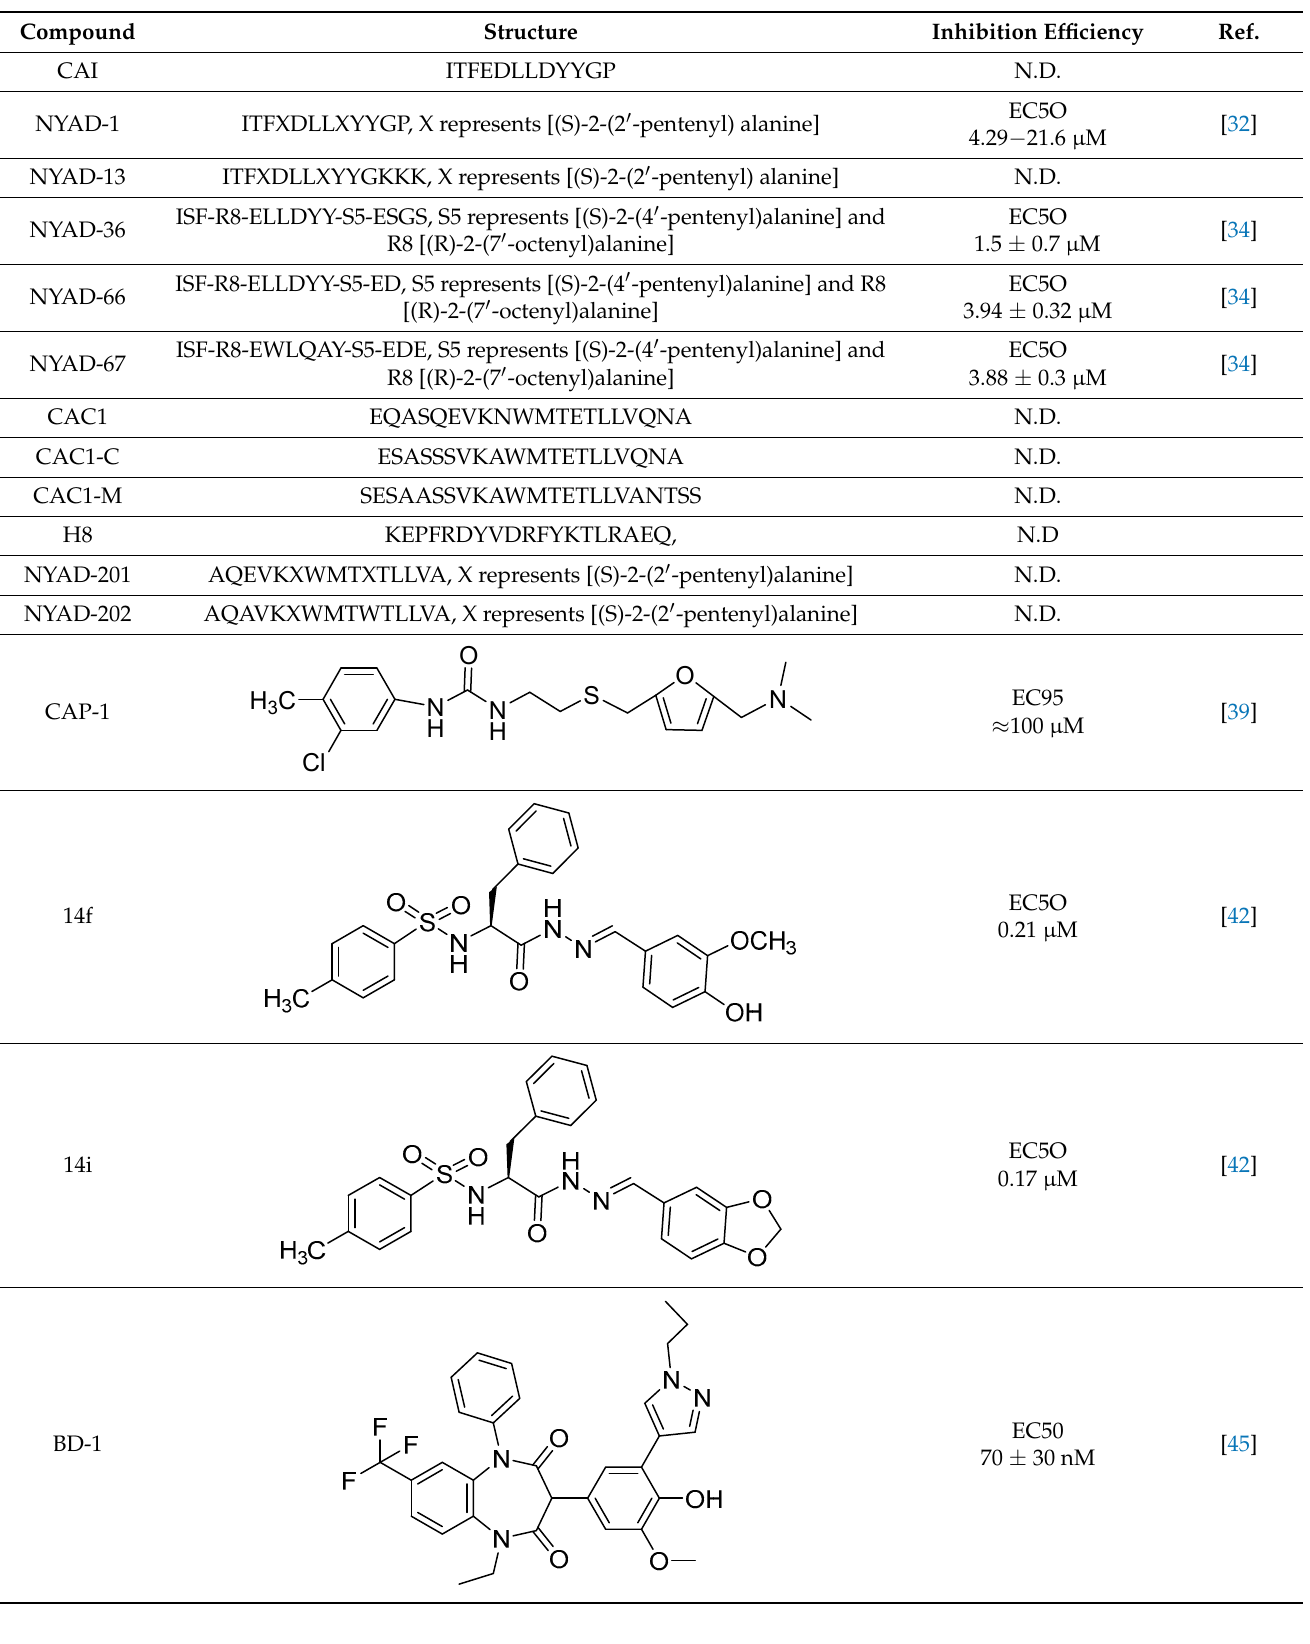
Table 1. List of compounds binding to retroviral capsid protein.